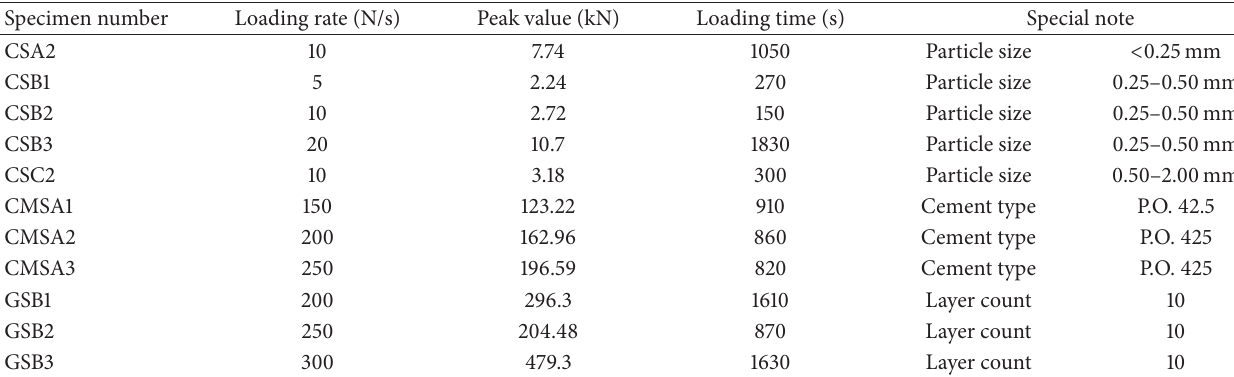
Table 1: Experimental parameters of specimens and work condition